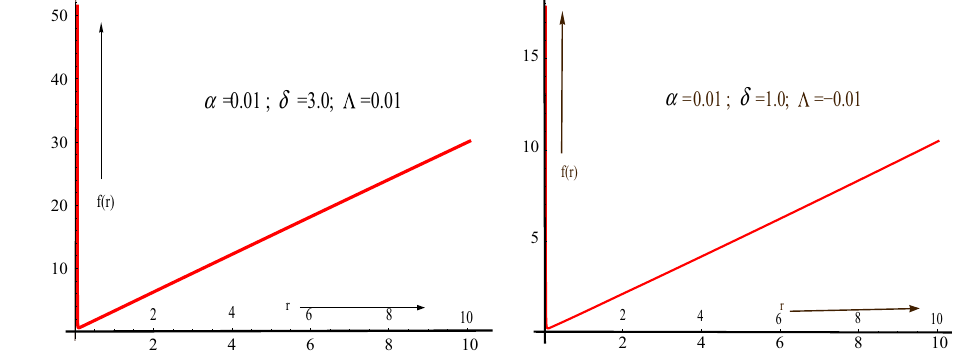
Fig. 1 Variation of f(r) with respect to r for positive values of α,δ . (Left panel) de-Sitter spaces (right panel) anti de-Sitter spaces